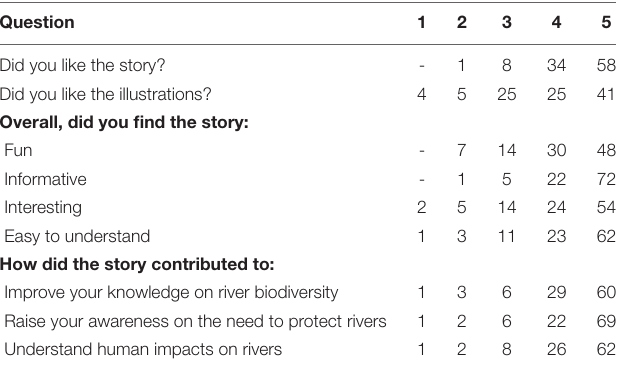
TABLE 3 | Answers (%) from the appreciation